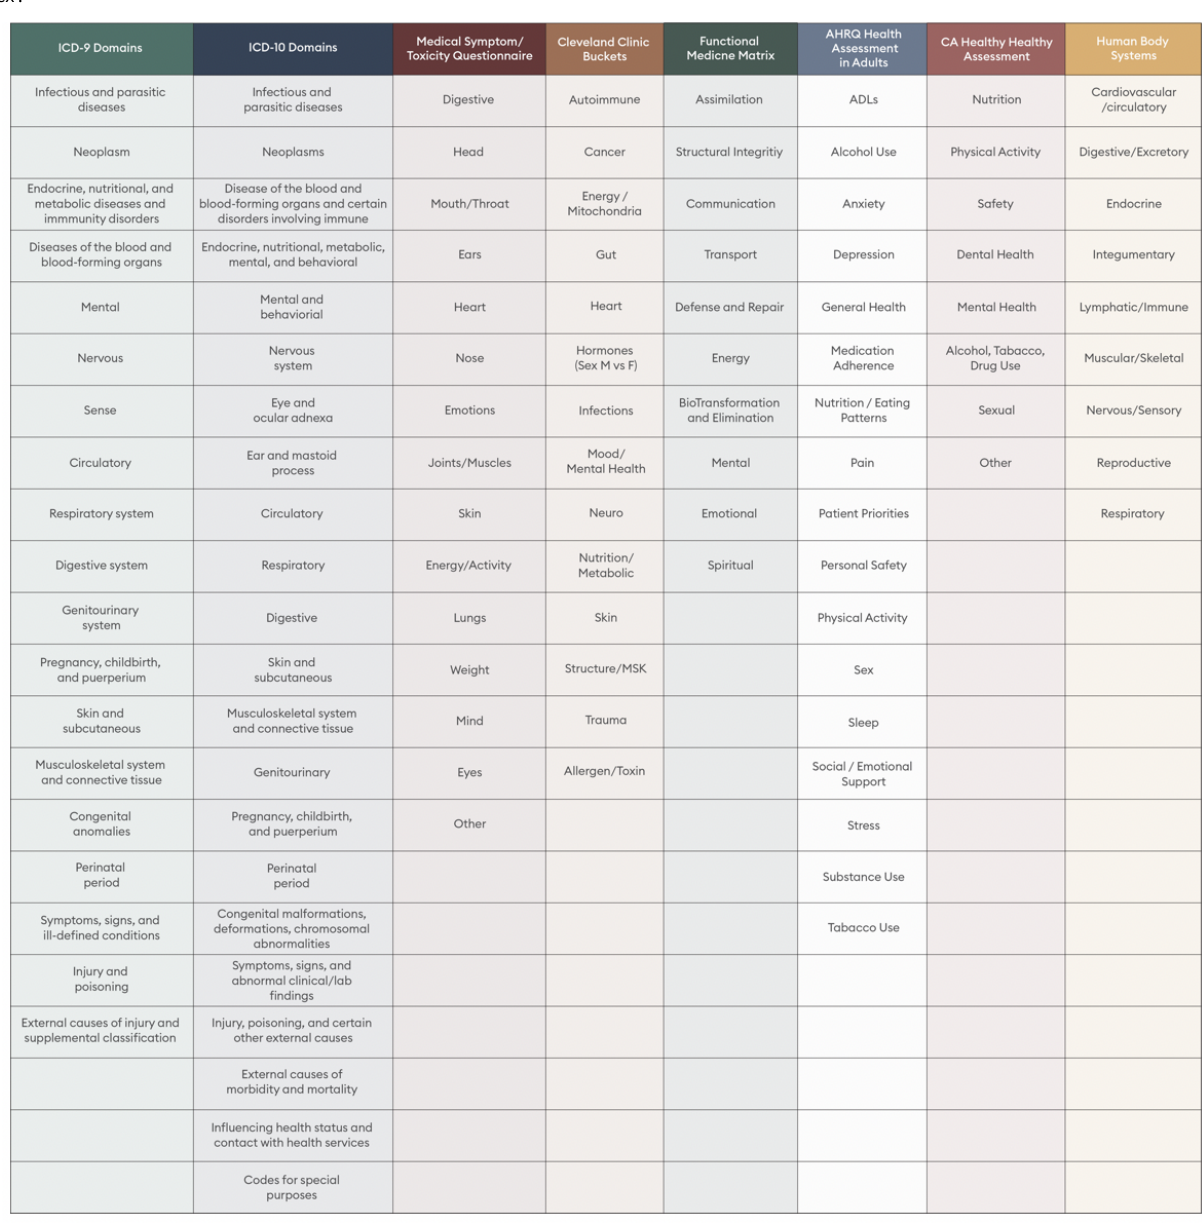
Figure 2. Logic for PSI bin relabeling with patient facing terminology to reflect bodily systems. ADL: activities of daily living; PSI: Parsley Symptom